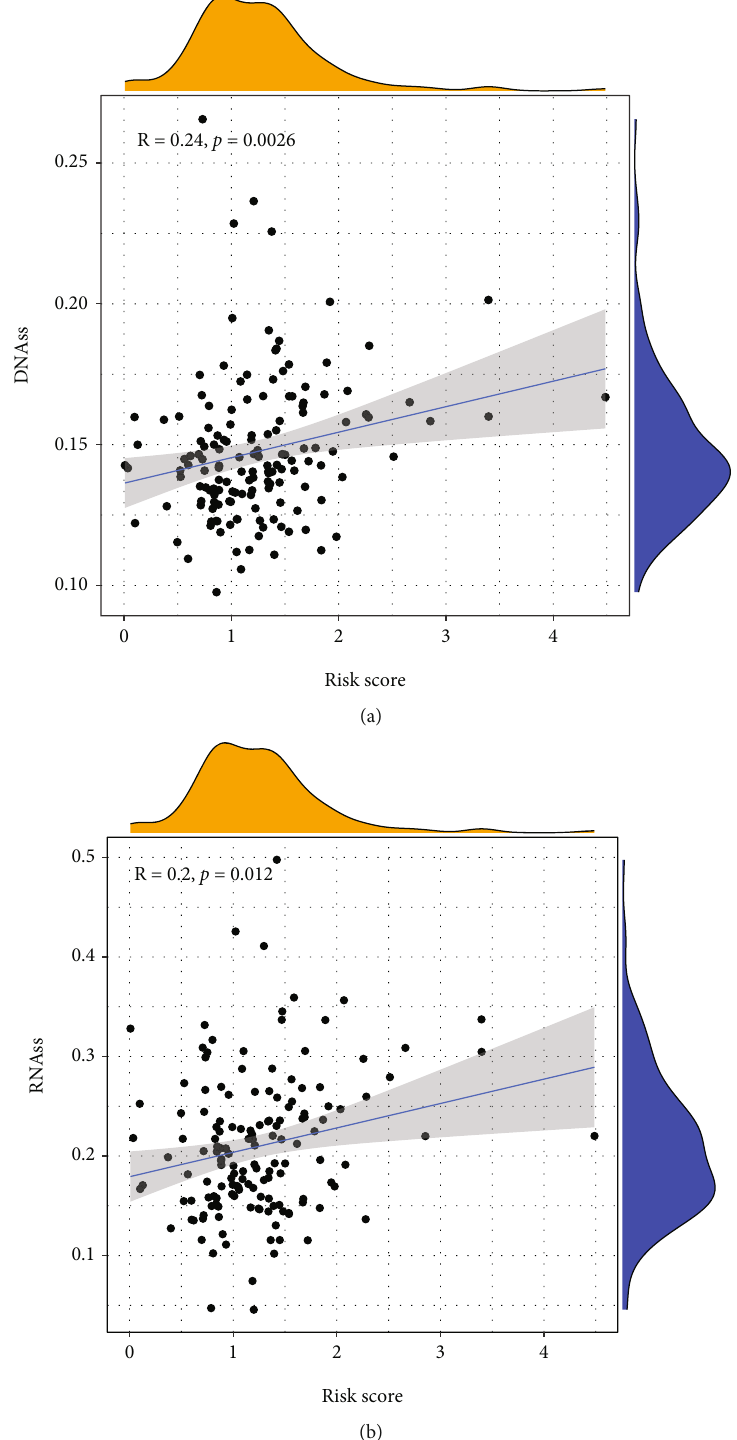
Figure 9: The relationships between risk score and (a) DNAss and (b)